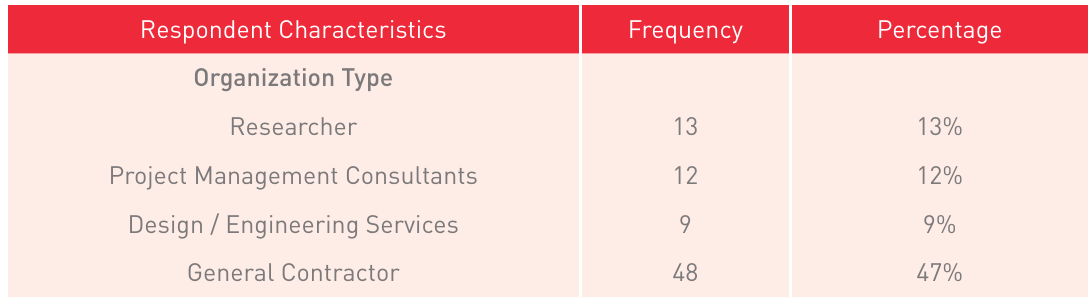
Respondent characteristics of Barriers to Interface Management Structured Questionnaire